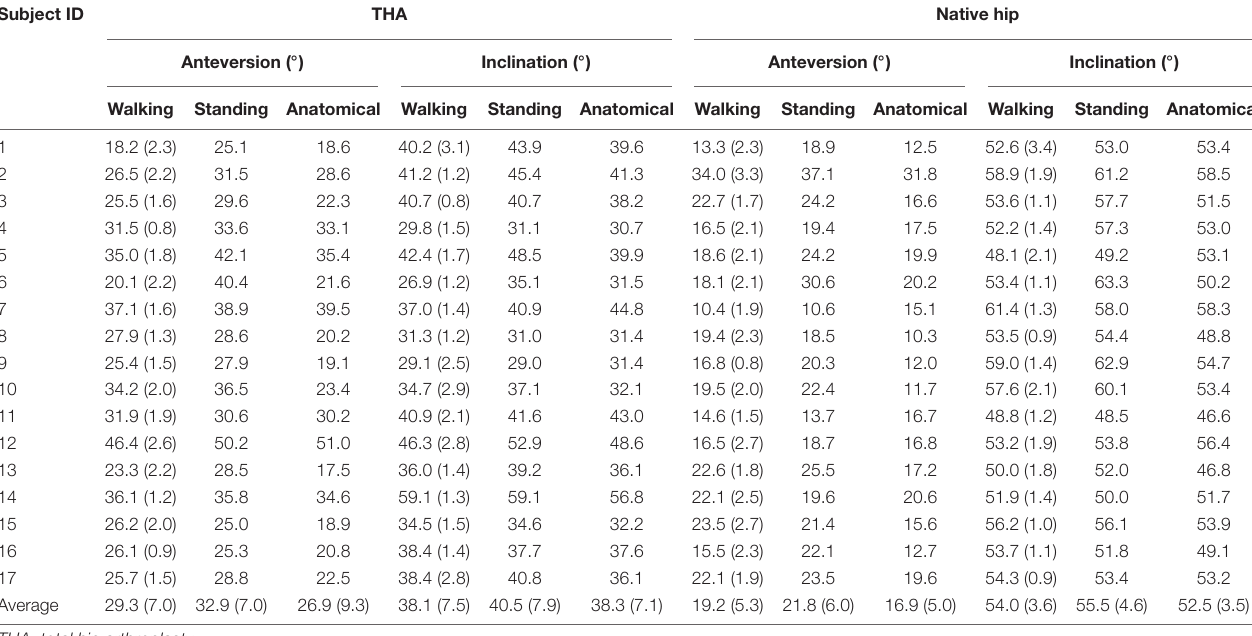
TABLE 1 | The anatomical acetabular orientation and functional acetabular orientation at standing (static) position and during level walking (dynamic) were calculated in both THA and native hips of unilateral THA patients.